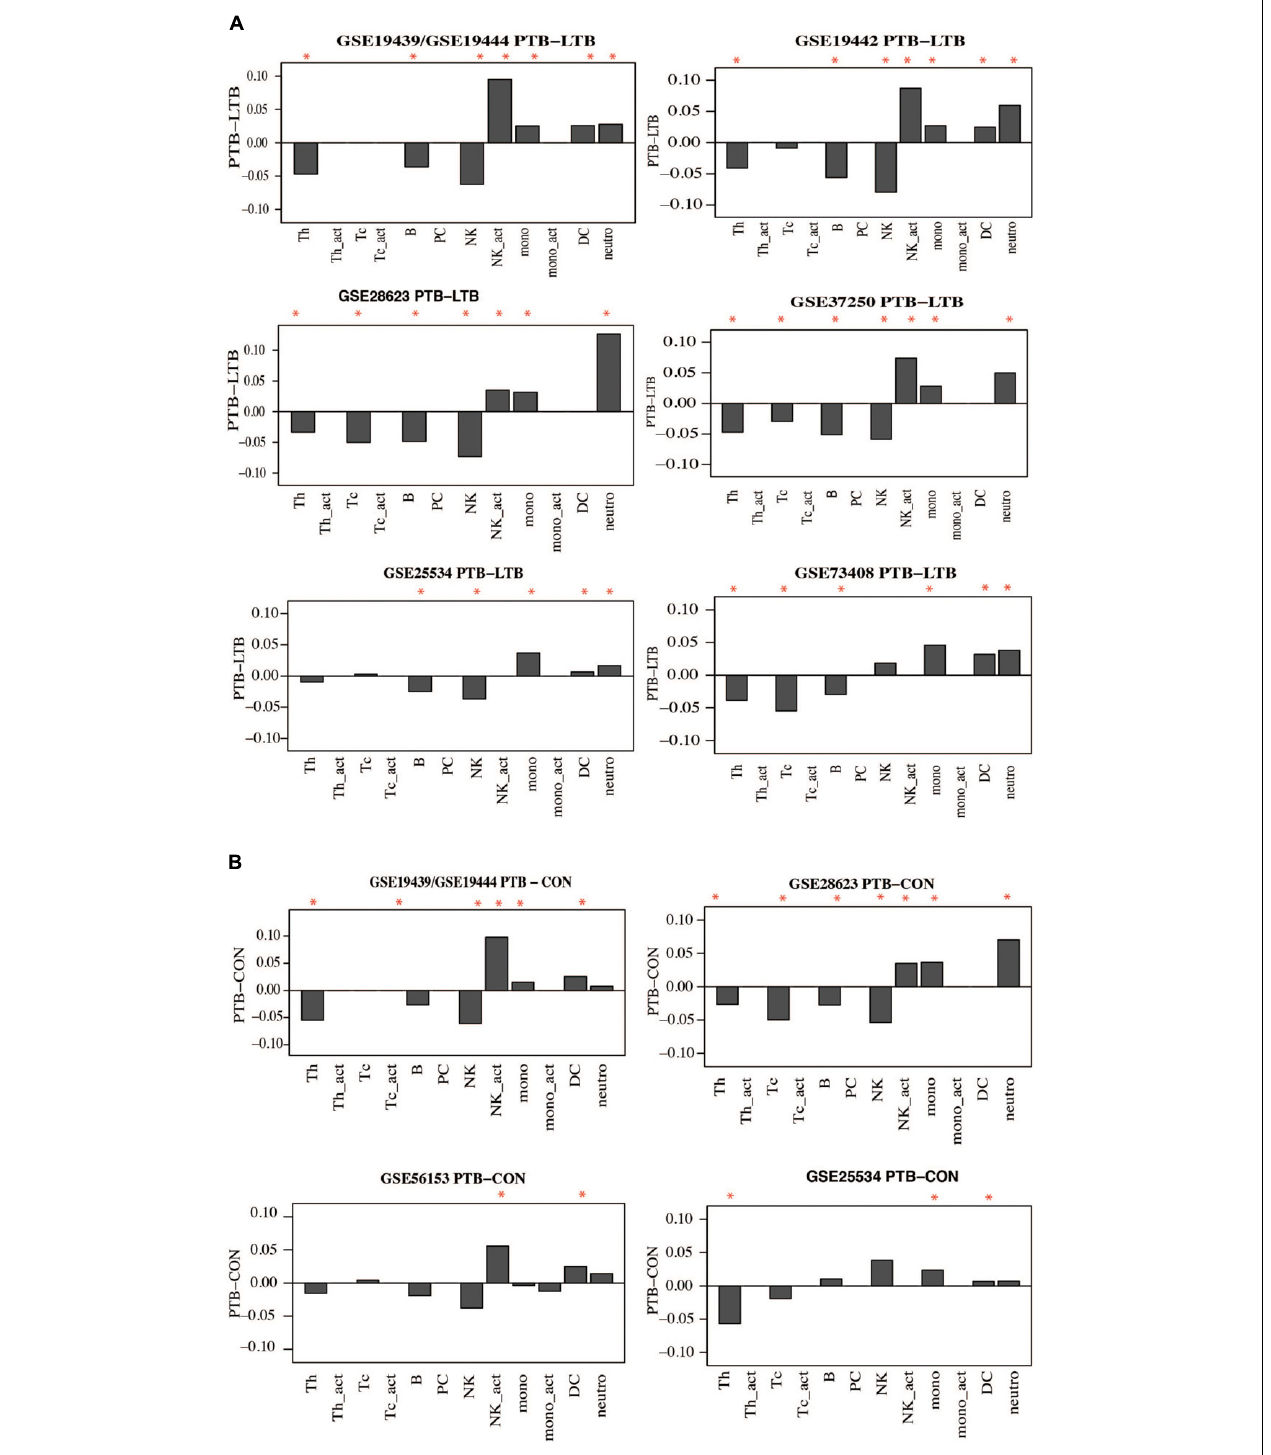
FIGURE 7 | Difference in Immune cell proportions in adult tuberculosis. Gene expression signals were used to deconvolute cell proprtions in whole blood collected from TB and controls using the CellMix package. The median for each cell component per clinical phenotype was determined. Median cell proportions from controls were substracted from medians from active TB. (A) Immune cell proportion difference between active TB and latent TB. (B) Difference in active TB and uninfected controls. Red asterisks indicate those that are siginificant ( p < 0.05) based on a Student’s t -test.